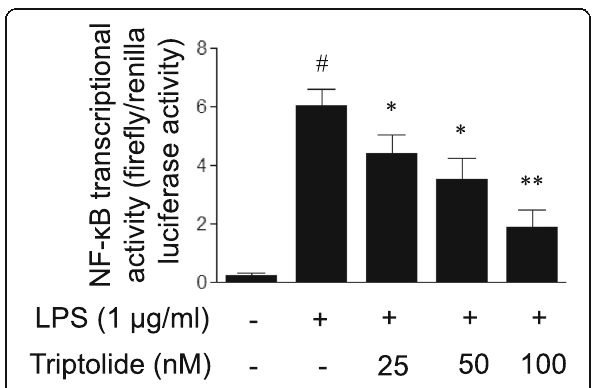
Fig. 7 The effects of triptolide on lipopolysaccharide (LPS)-induced NF- κ B transcriptional activation in human umbilical vein endothelial cells (HUVECs). HUVECs were treated with LPS (1 μ g/mL) in the presence or absence of triptolide (25, 50, or 100 nM) for 1 h. The NF- κ B transcriptional activity in HUVECs was determined using a dual luciferase reporter assay system as described in the method section. The data were presented as a ratio of firefly to Renilla luciferase activities. Data are expressed as the mean ± standard error of the mean. * p < 0.05, ** p < 0.01 compared with LPS treatment alone. # p < 0.05 compared with control